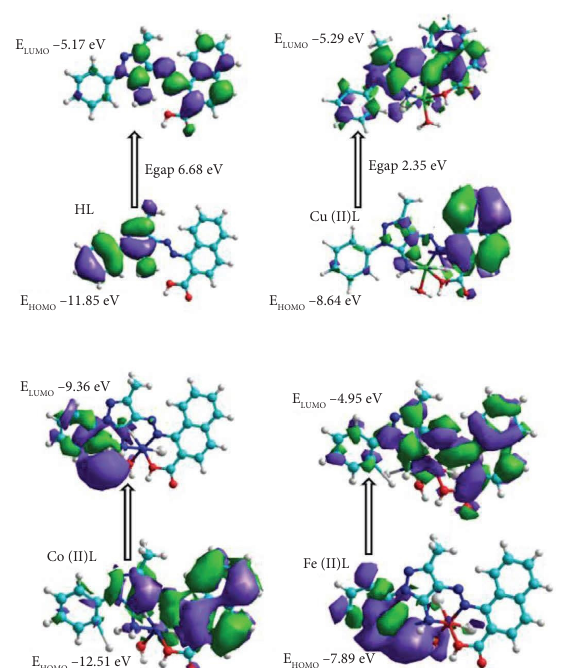
Figure 9: Te charge density maps of HOMO and LUMO maps of the studied ligand and its